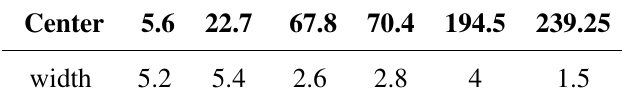
Table 1. Peak coordinates for the simulation presented in Figure 1.